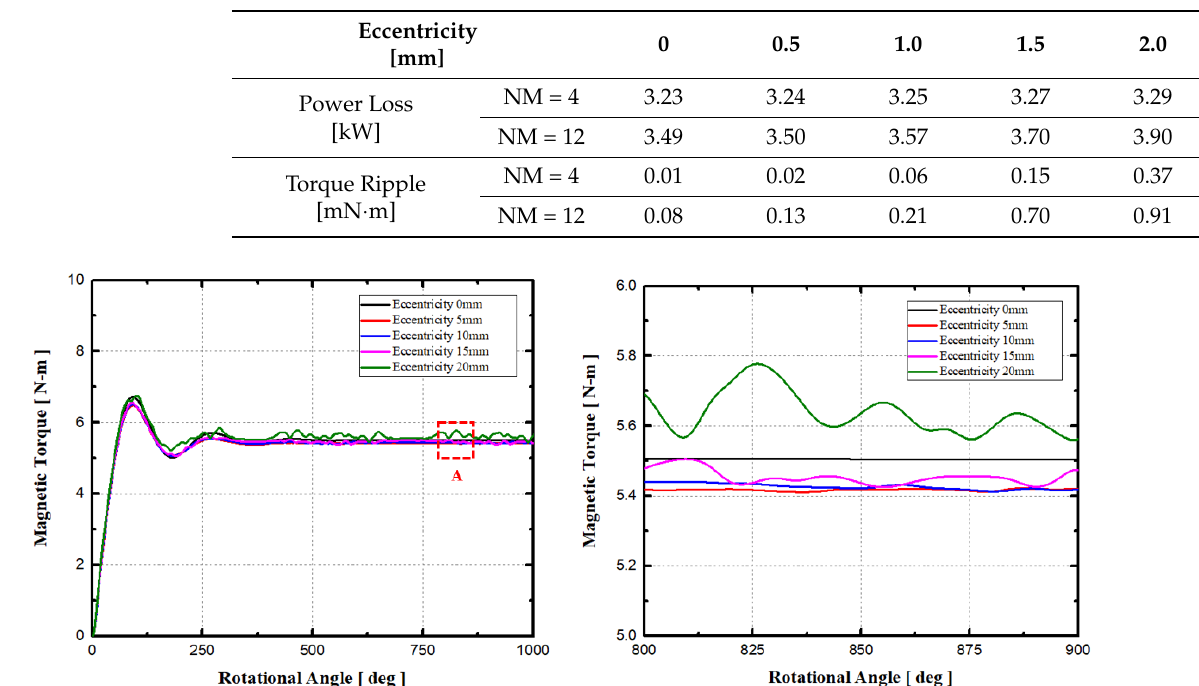
Figure 14. Changes in torque ripple according to eccentricity. Table 6. Mean heating value and torque ripple in the billet. (NM = Number of